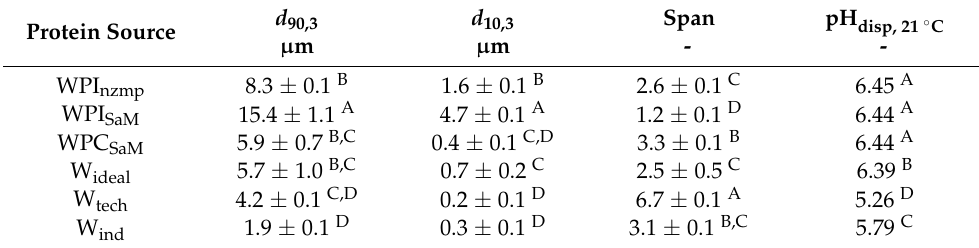
Table 2. Particle size parameters and pH at 21 ◦ C of dispersions of whey protein pectin complexes